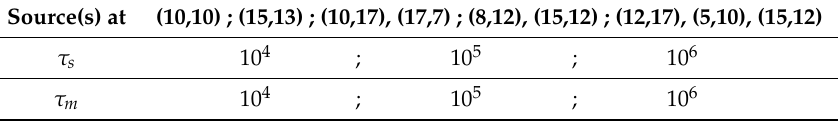
Table 1. Parameters used for simulation runs shown in Figure